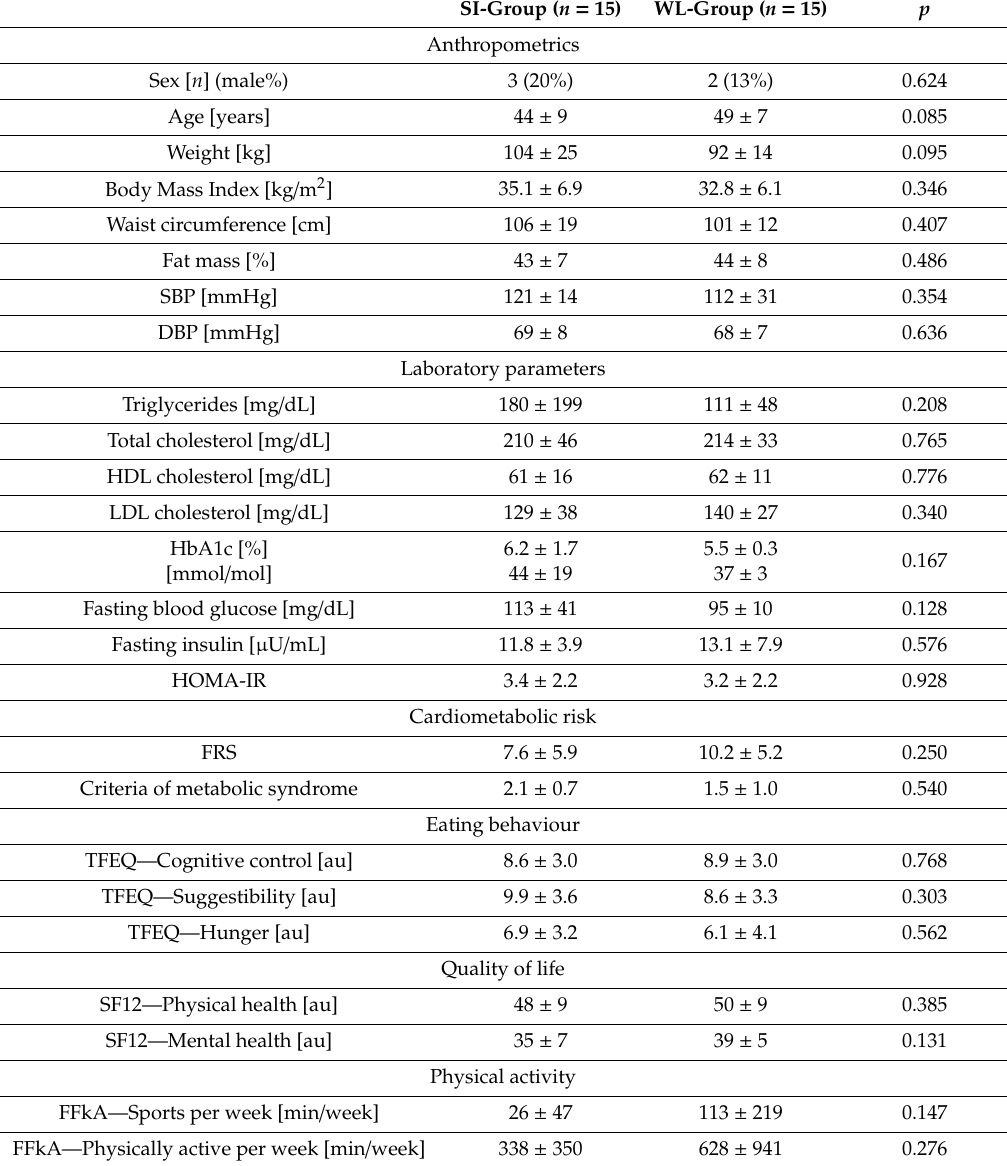
Table 1. Baseline